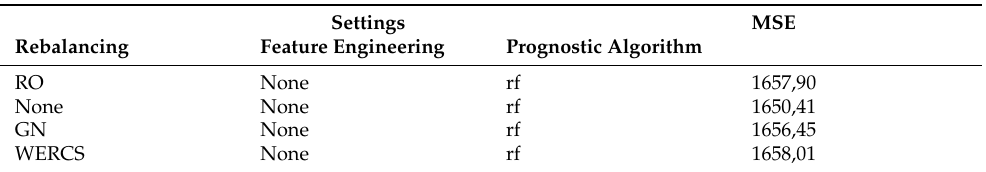
Table 9. A comparison of applying different rebalancing methodologies and the resulting MSEs on dataset FD001.